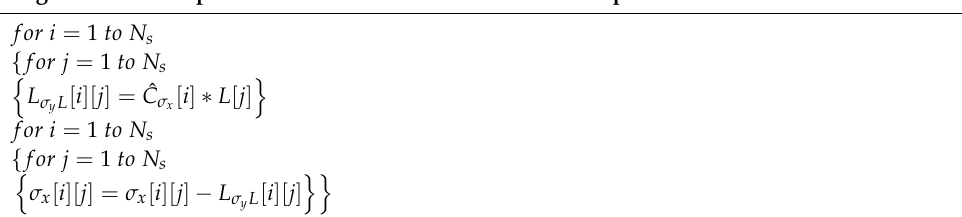
Algorithm 7: Compute the error covariance measurement